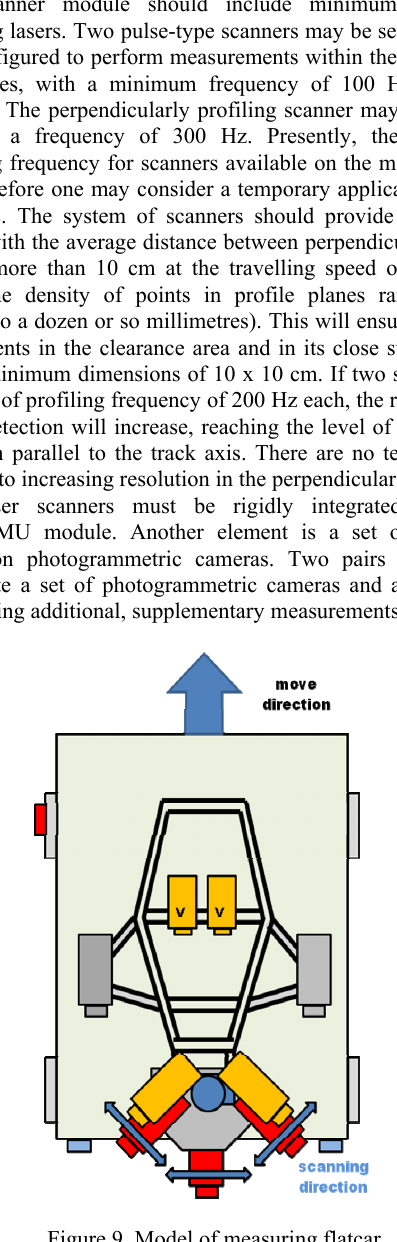
Figure 9. Model of measuring